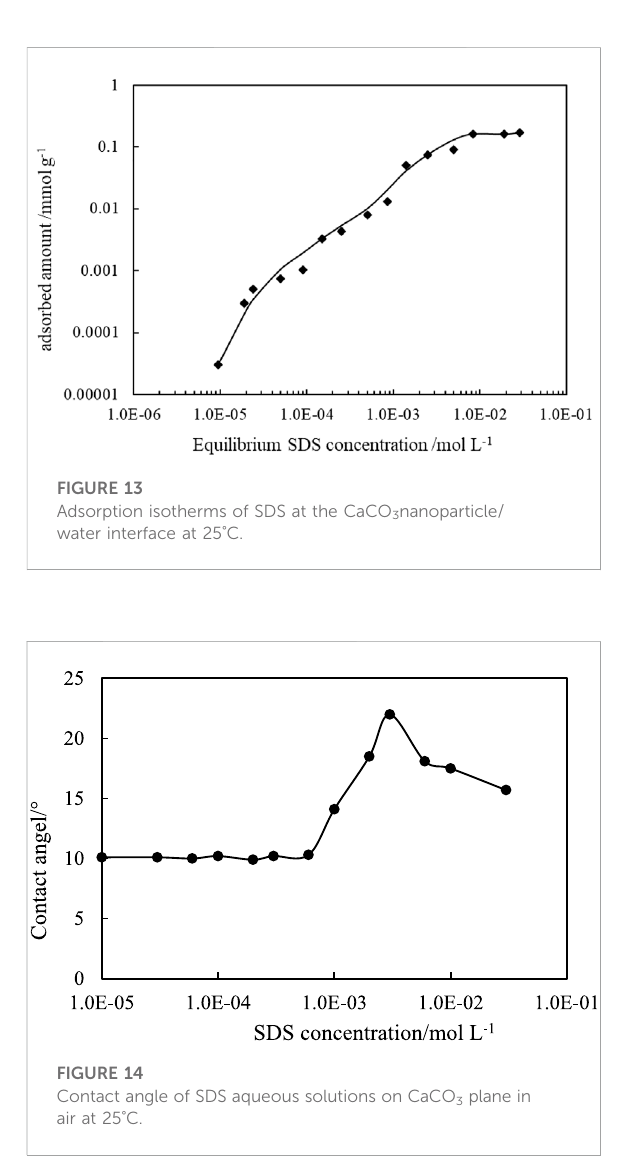
FIGURE 14 Contact angle of SDS aqueous solutions on CaCO 3 plane in air at 25 ° C.